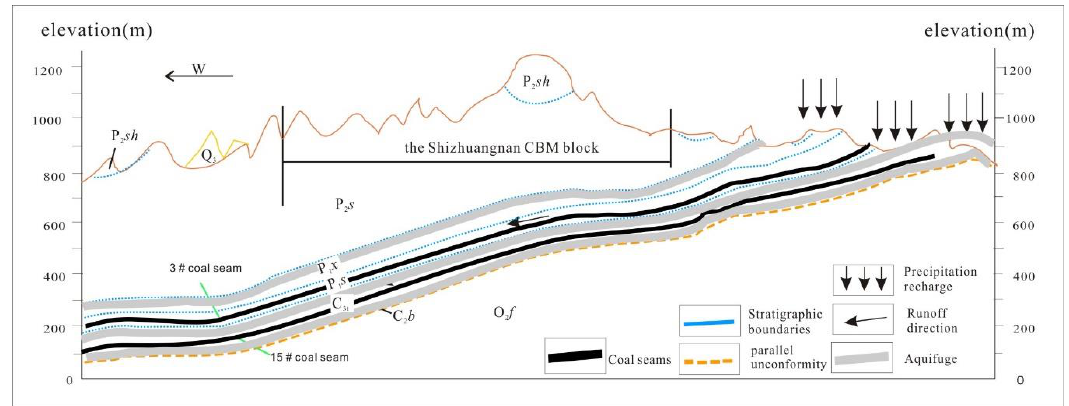
Figure 2. Hydrogeological conditions in the Shizhuangnan block of the Qinshui Basin. CBM: coalbed methane.